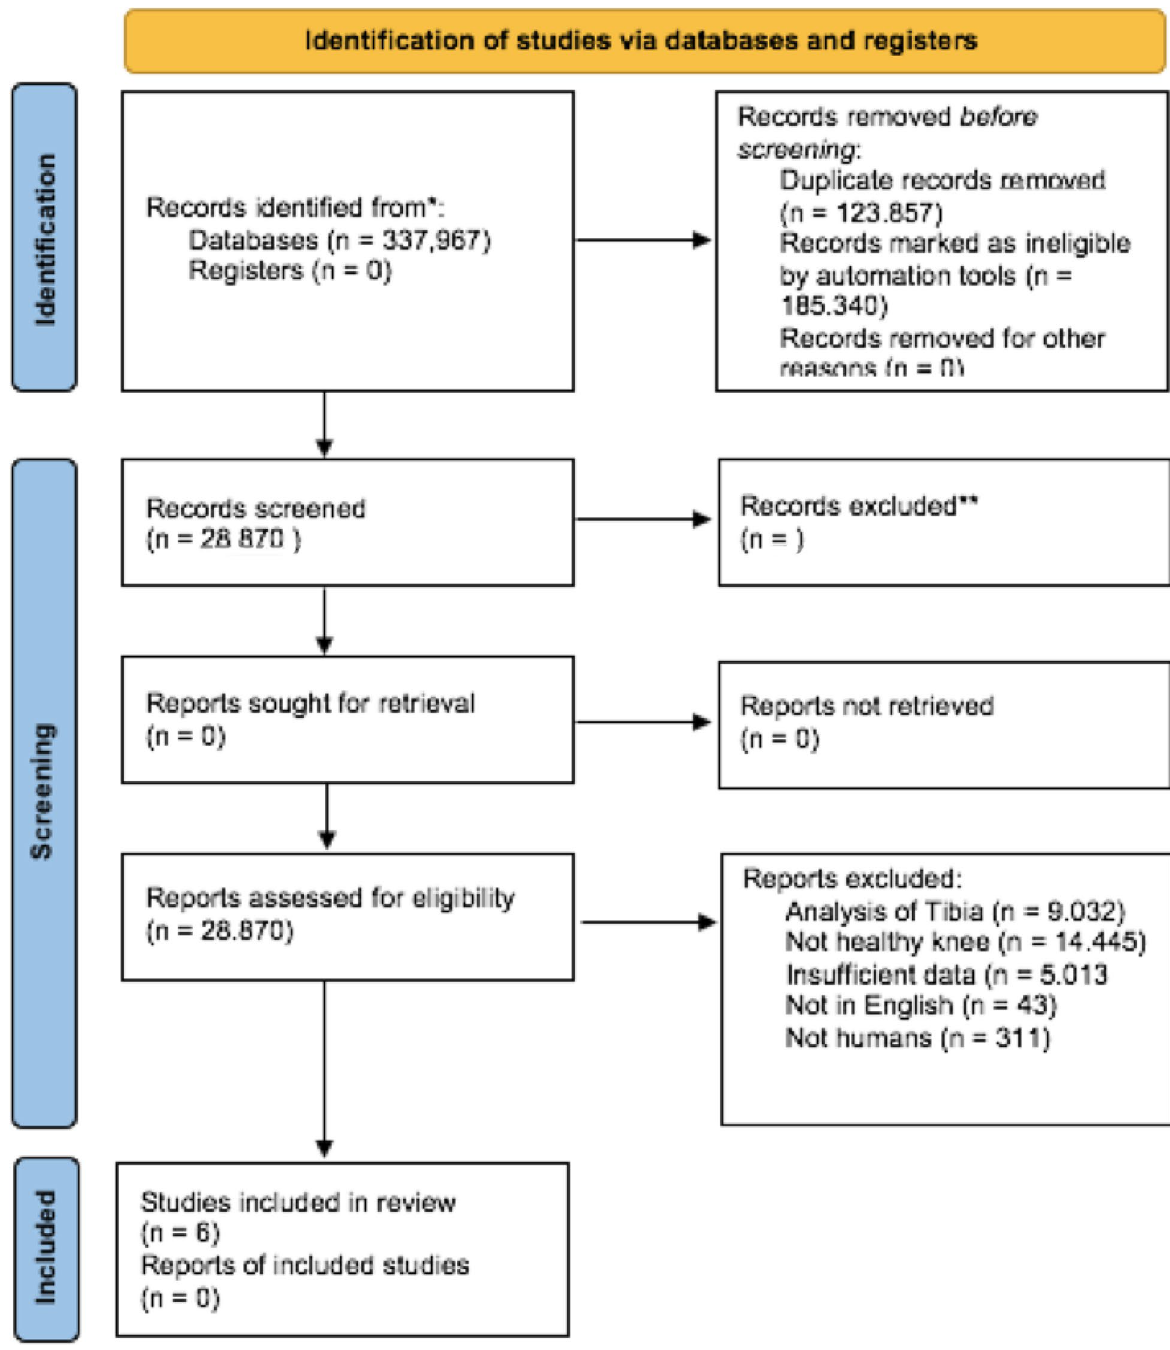
Fig. 1 Flowchart of the Preferred Reporting Items for Systematic Reviews and Meta-Analyses